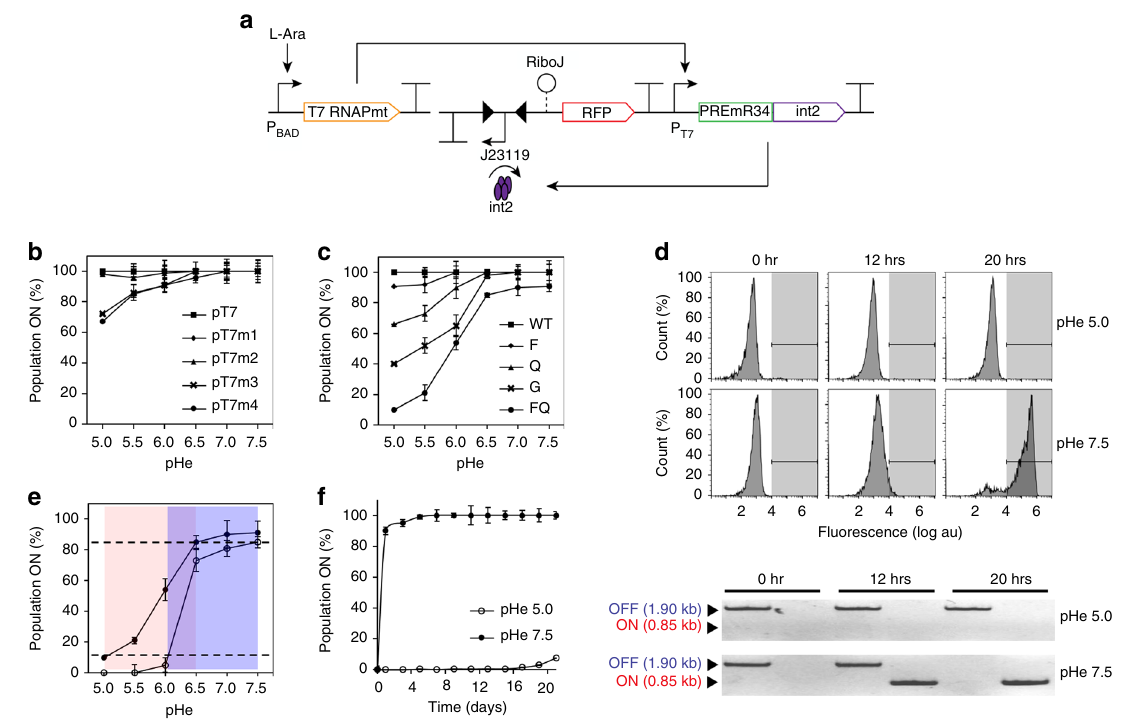
Fig. 3 Characterization of the digitalized pH-sensing system. a Schematic of the digitalized pH-sensing system. The system regulates the pH-dependent expression of an integrase (int2) that catalyzes the unidirectional reorientation of a strong constitutive promoter (BBa_J23119) fl anked by its recognition sequences. At acidic pH (pHe 5.0), integrase expression is suppressed, and cells are maintained in the “ OFF ” state (no fl uorescence). At neutral pH (pHe 7.5), integrase expression leads to the reorientation of the promoter J23119 to drive RFP expression, and cells are switched to the “ ON ” state ( high fl uorescence ). b Outputs of the digital pH-sensing systems constructed from the T7 promoter variants. c Outputs of the digitalized pH-sensing systems constructed from the T7RNAP variants. d Time-course characterization of the digitalized pH-sensing system. Top : The histograms show the fl uorescence distribution of the cell population induced at pHe 5.0 or 7.5 over time. The shaded regions indicate the “ ON ” state ( red fl uorescence > 10 3.8 au). Bottom : Gel electrophoresis of PCR products corresponding to the “ ON ” (0.85kb) and “ OFF ” (1.90kb) states of the cell population induced at pHe 5.0 or 7.5 over time. e Tuning of the transition band of the digital pH-sensing system through titration of the intracellular T7RNAP concentration. Low-threshold ( fi lled circles ) and high-threshold ( open circles ) transition bands were obtained at near-saturated (0.1%m/v) and lower induction concentrations (0.002% m/v) of L -arabinose, respectively. The shaded regions indicate the transition regions. The dashed lines indicate 10% and 85% population switching. f Stability assessment of the digitalized pH-sensing system at pHe 5.0 ( blue ) and pHe 7.5 ( red ) (with 0.002% m/v L -arabinose) over long periods. The switching behavior of the system was monitored daily over a 21-day period. The data represent the mean of three independent experiments performed on different